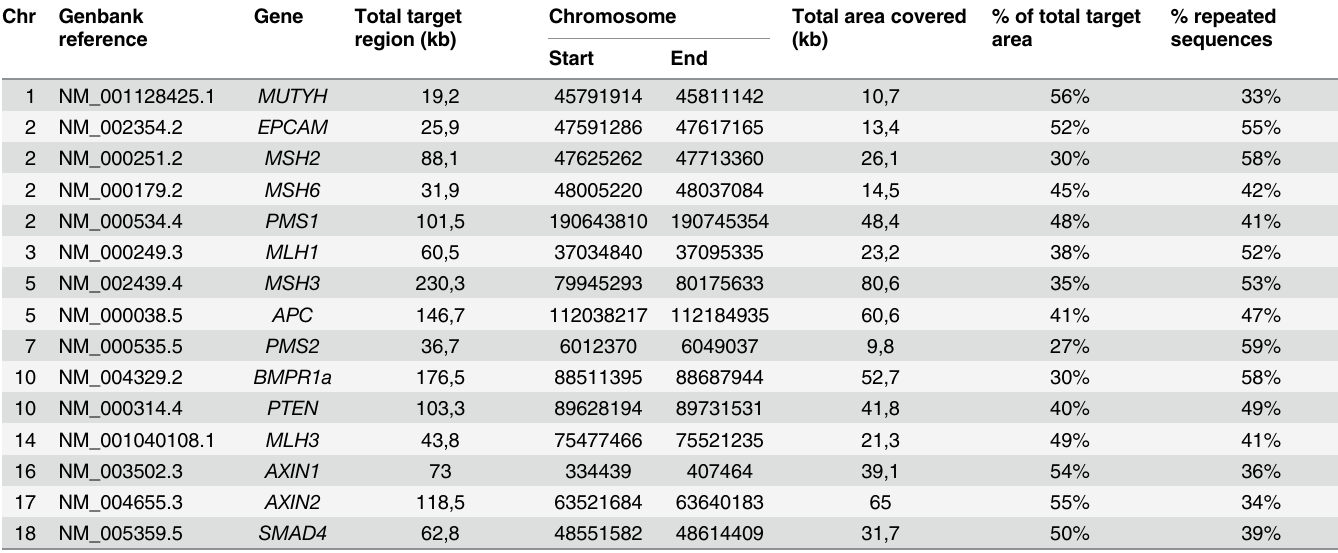
Table 2. Custom-designed baits used for Sureselect target enrichment of 15 CRC susceptibility genes.